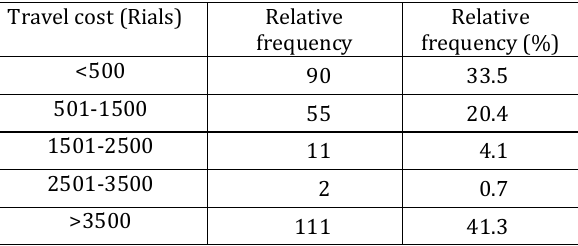
Table 3. Travel costs to visit the forest park